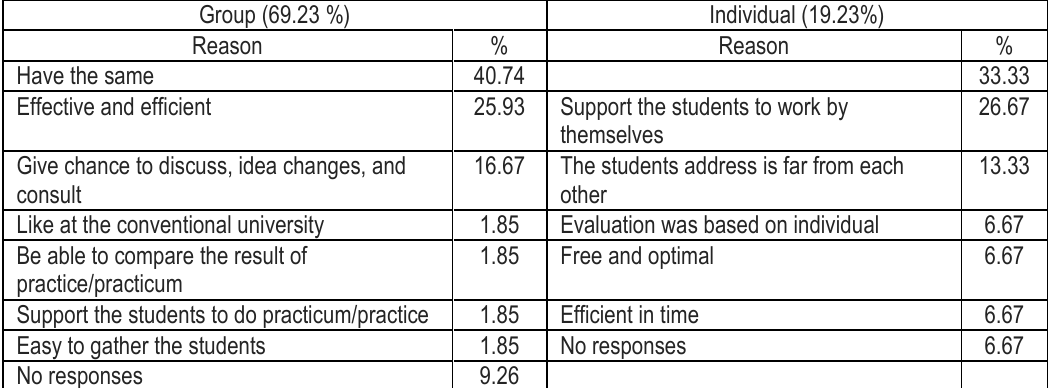
Table 6. Respondents’ Idea on the Implementation of Practice and